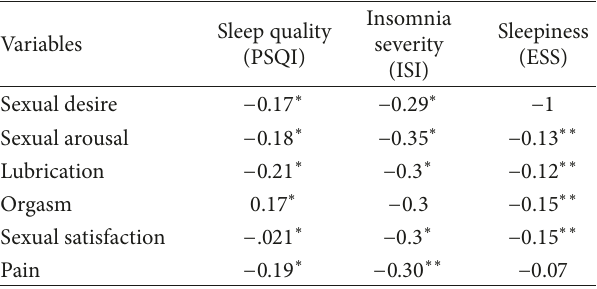
Table 4: The relation of sleep quality and sleep disturbances with sexual function domains.